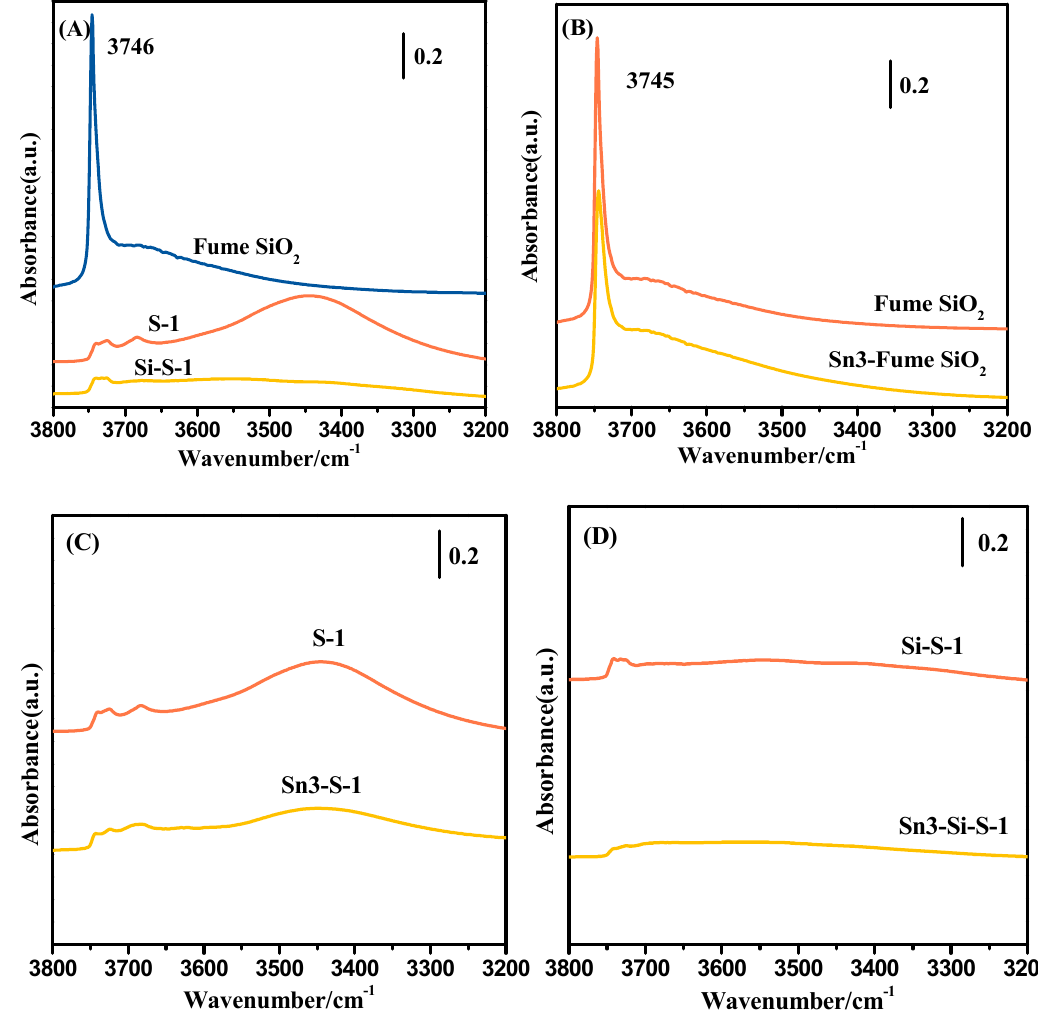
Figure 4. Hydroxyl stretching FT-IR spectra of different samples: S-1, Si-S-1, and fume SiO 2 matrixes ( A ); fume SiO 2 and Sn3-fume SiO 2 ( B ); S-1 and Sn3-S-1 ( C ), Si-S-1 and Sn3-Si-S-1 ( D ).